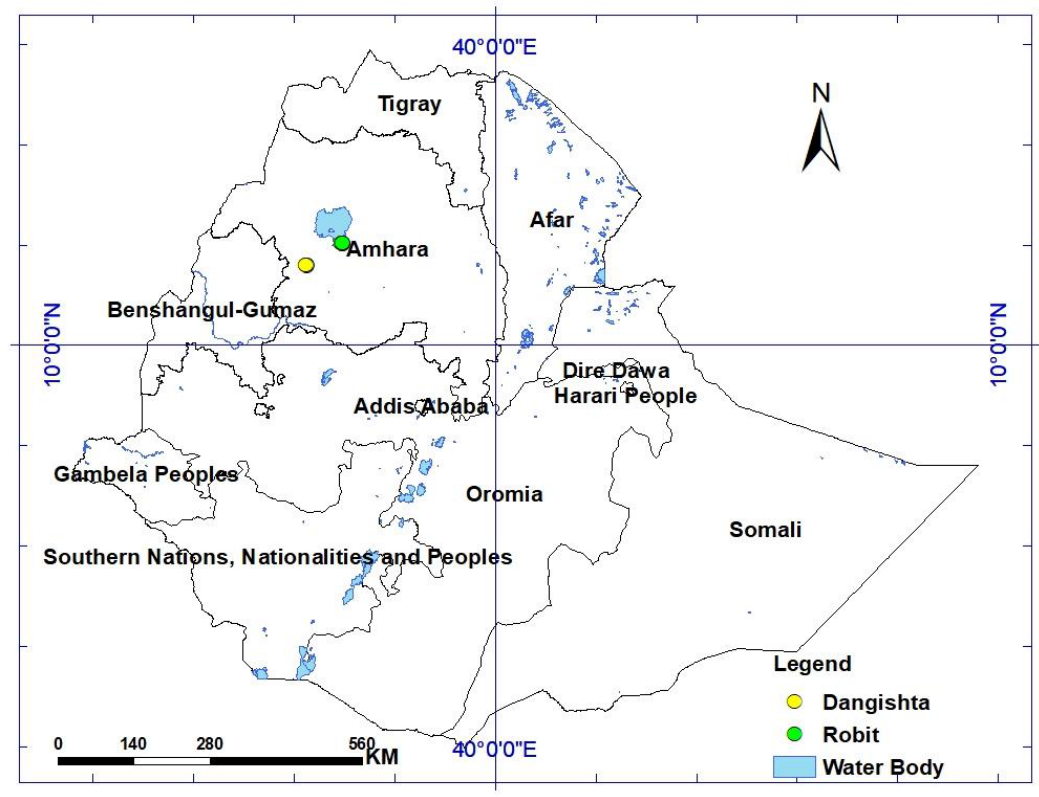
Figure 1. Dangishta and Robit experimental sites in Ethiopia; adopted from Assefa et al. [37].